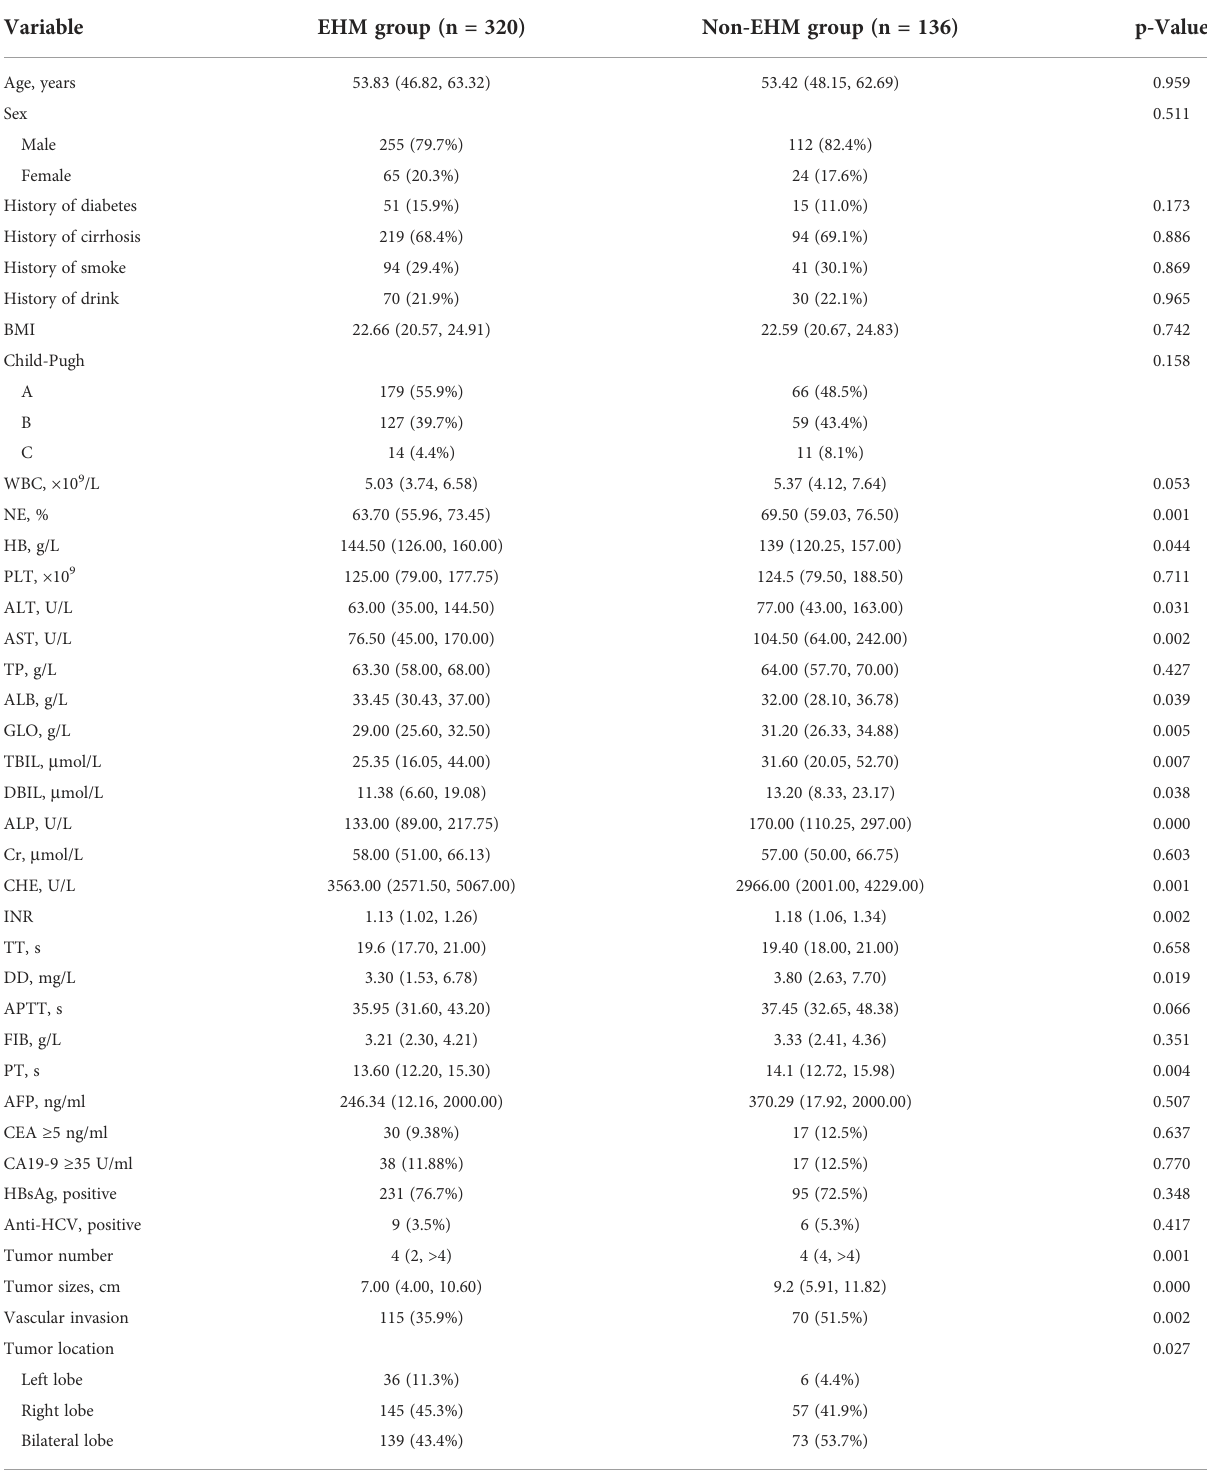
TABLE 2 Univariate analysis for predicting EHM in the training